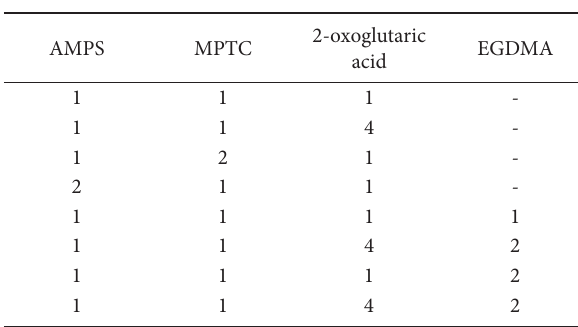
Table 1. Th e ratio of monomers (molar ratio), initiator and crosslink- ing agent used in various synthesis reactions. In this table the ini- tiator concentrations 1-4 refer to the ratio of monomers and 0.25% mole of initiator (i.e. for ‘1’, and with ‘4’ corresponding to 1%).